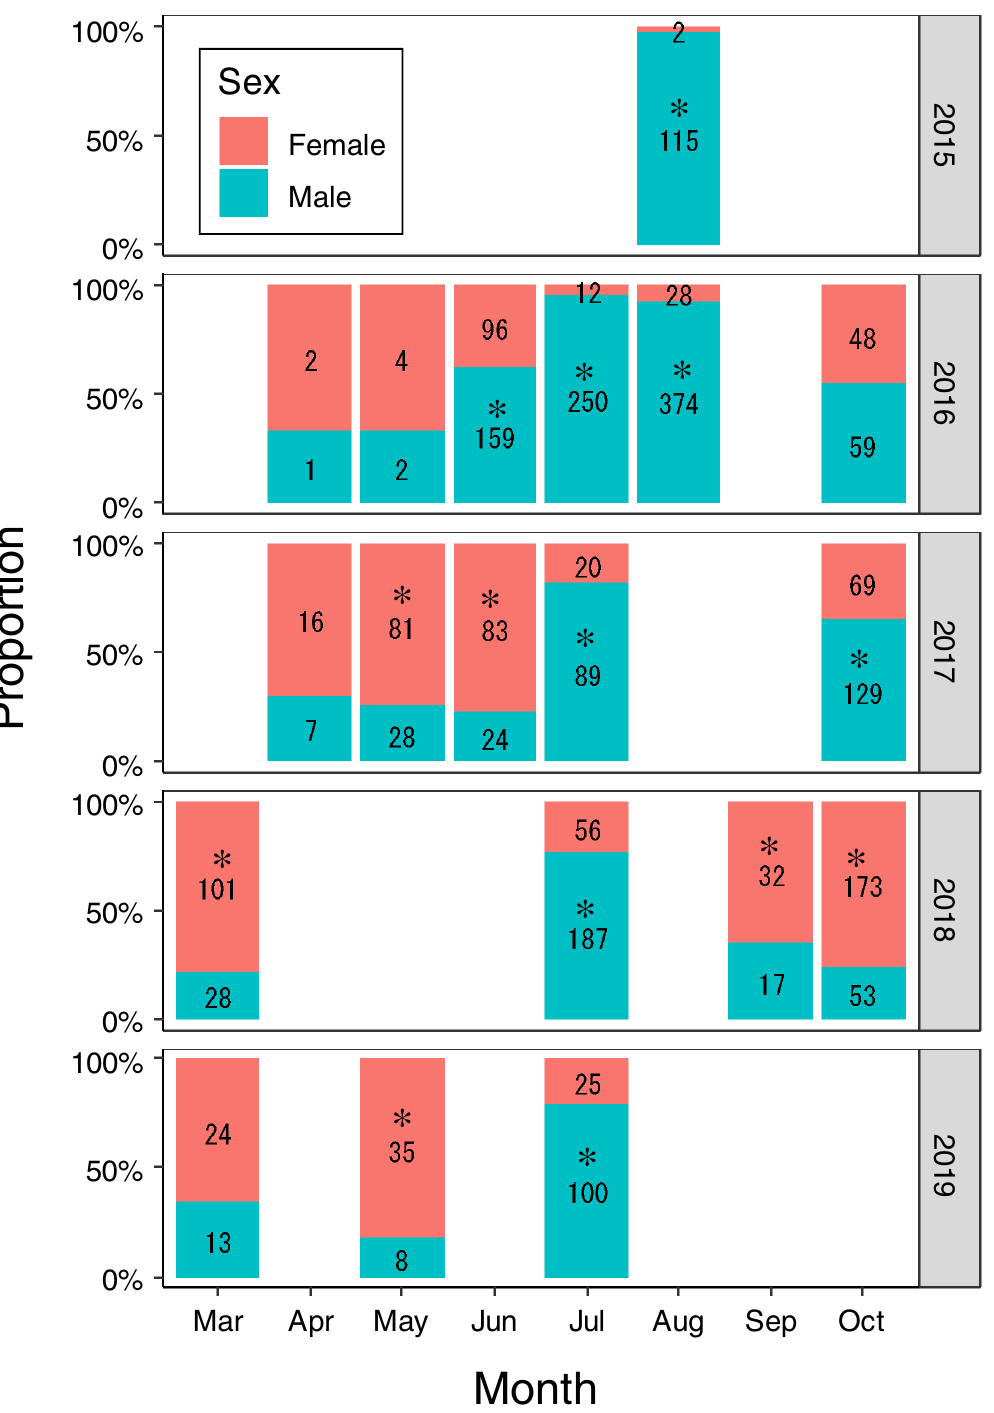
Figure 4. Monthly proportion of females and males of crawling Laguncula pulchella individuals (≥ 25 mm shell height) collected in Matsukawaura Lagoon between 2015 and 2019. Numerals show the number of individuals. Asterisks above the numerals indicate the significant difference from 1:1 ( P < 0.05, binomial